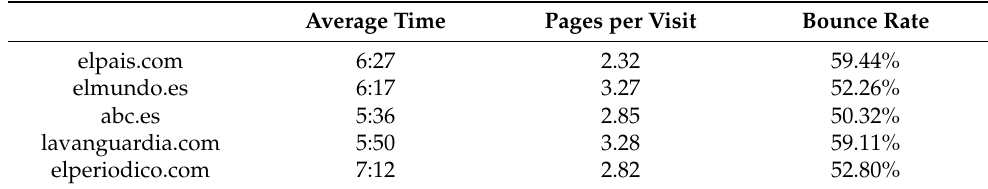
Table 2. Online media access channels. Compiled by the authors on the basis of Similarweb (2021) [42] data.